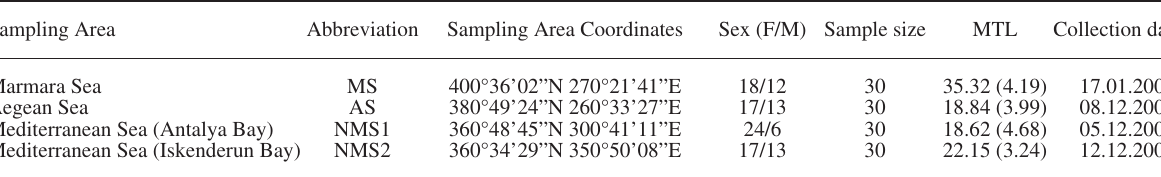
Table 1. – Sampling details of S. officinalis used in this study. mTl, mean total length (mm). Standard deviations of mTl are given in brackets. F, female; m, male. Sampling